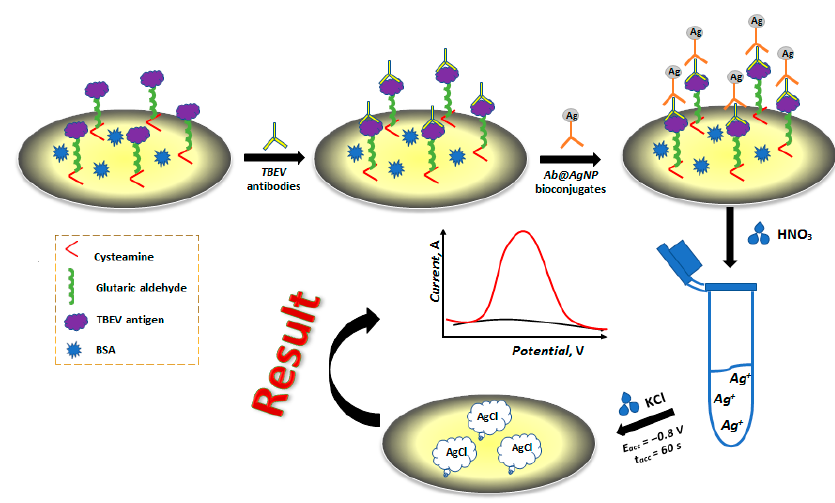
Figure 1. Scheme of the electrochemical immunosensor preparation and principle of antibody detection.